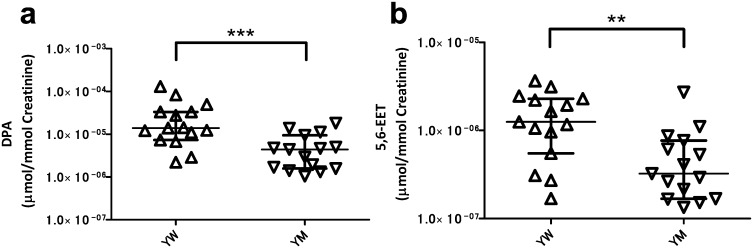
The gender-related urinary oxylipins in young age.Young women had higher concentration of DPA and 5,6-EET than young men (a and b). Open triangles and open inverted triangles show young women (YW) and young men (YM), respectively. The center bars show median and interquartile values normalized to the respective creatinine level. **p < 0.01, ***p < 0.001 by the Mann-Whitney U-test.